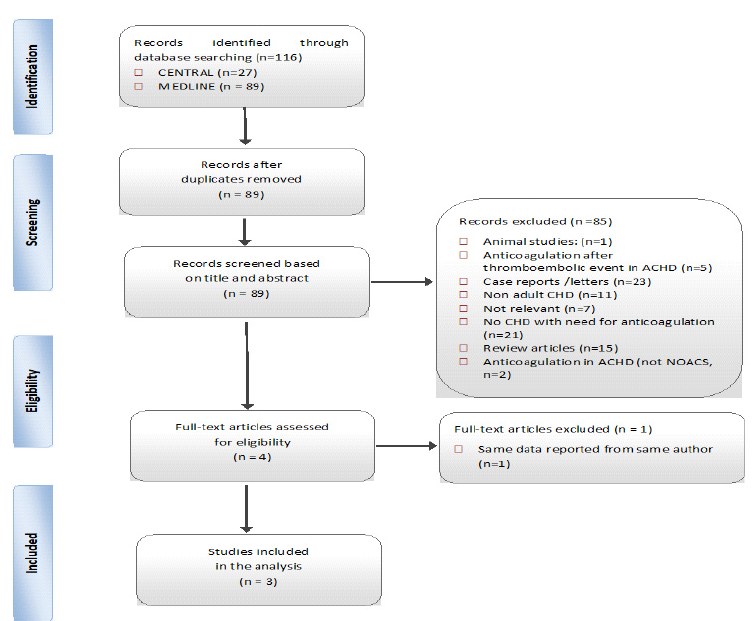
Figure 1. Summary of evidence of search and selection. Abbreviations: ACHD: adults with congenital heart disease; CHD: congenital heart disease, NOACs: